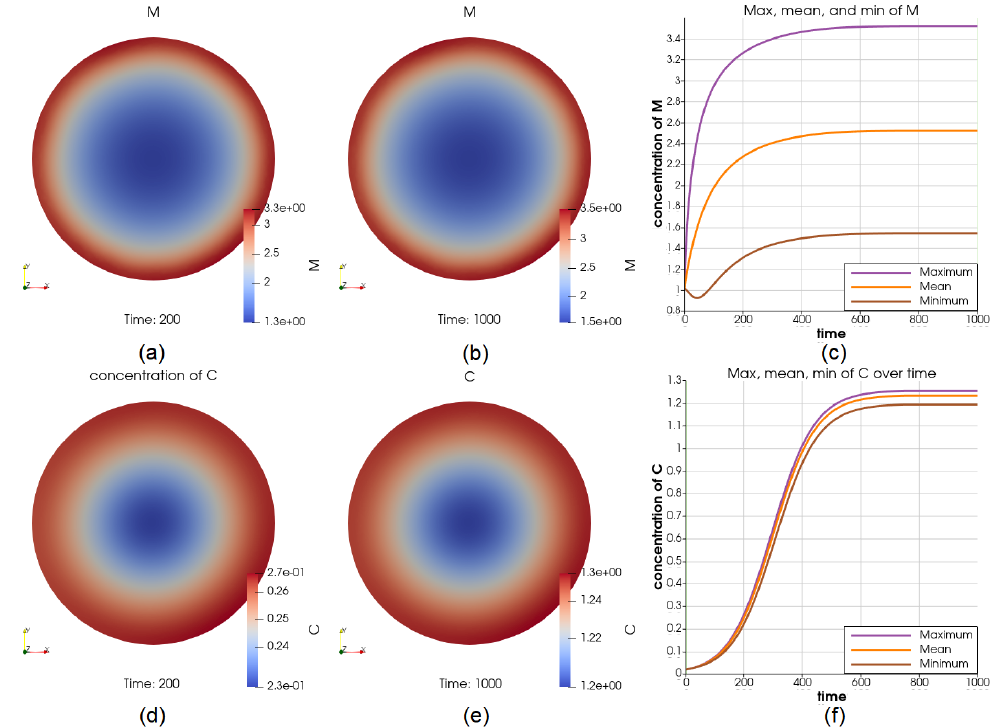
Figure 10. Illustrations for the case of a source of M on the boundary. Sub-figure ( a , b ) show the value of T c at t = 200 and t = 1000, respectively; ( c ) show the dynamics of the maximum and minimum of M , depicting that the value of M on the boundary is substantially higher than it is elsewhere; the cancer cell concentration at t = 200 and t = 1000 are shown in ( d , e ); the value of the maximum and minimum of C over the whole time interval is shown in ( f ). We can see that the cancer cell concentrations approach different steady-state values, positively related to the concentrations of